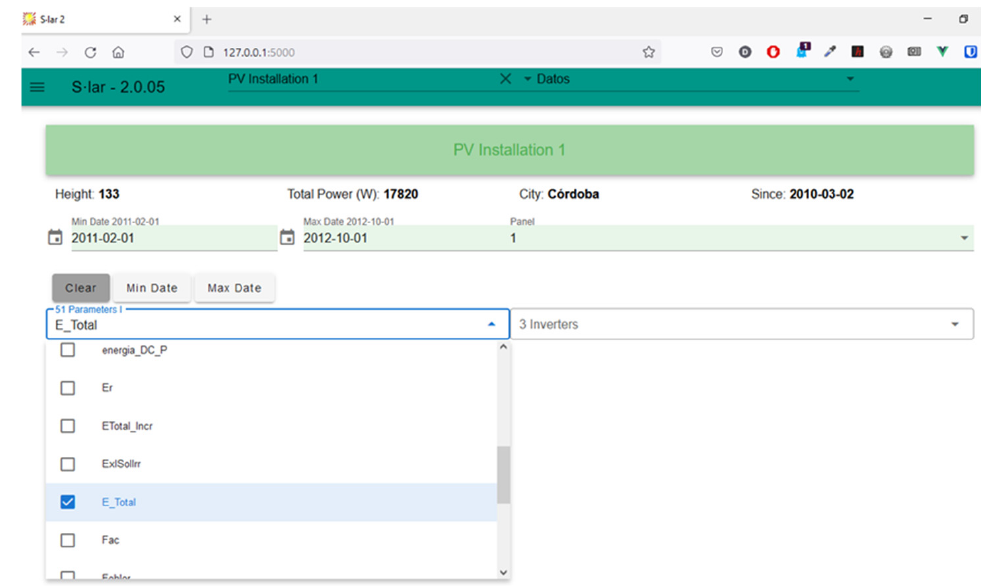
Figure 8. Image of the S·lar 2 application screen, in which the parameters measured by the chosen inverters can be selected.